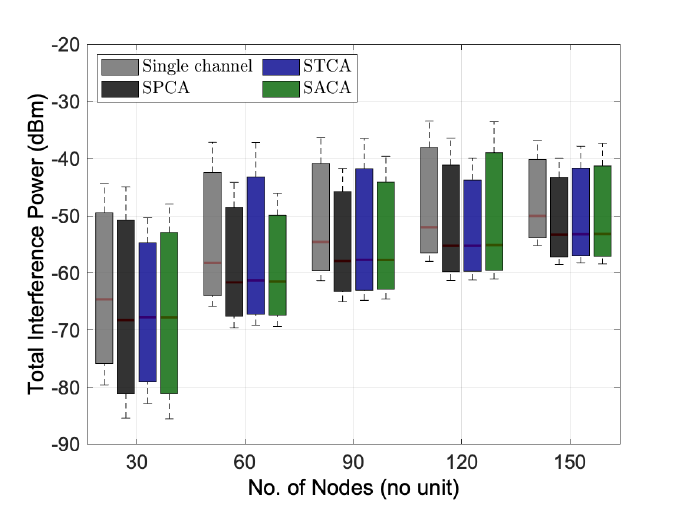
Figure 5. Performance comparison between different fixed channel allocation schemes for the distribution of total interference power versus the number of nodes.